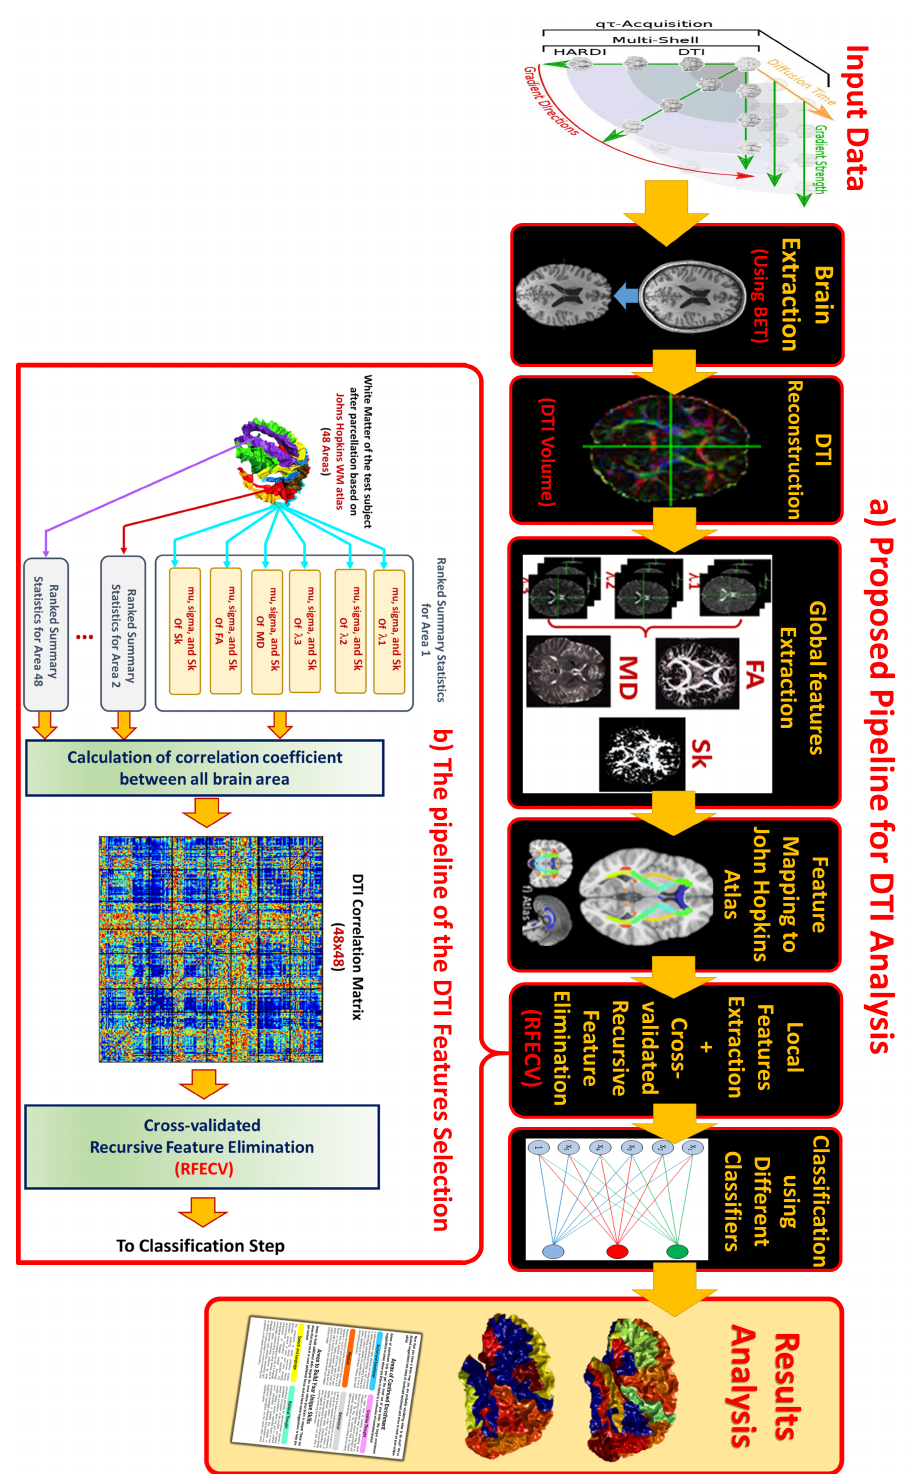
Figure 1. ( a ) Pipeline of the DTI-diagnosis algorithm. ( b ) Usage of the new derived feature represen- tation ˆ F and feature selection before